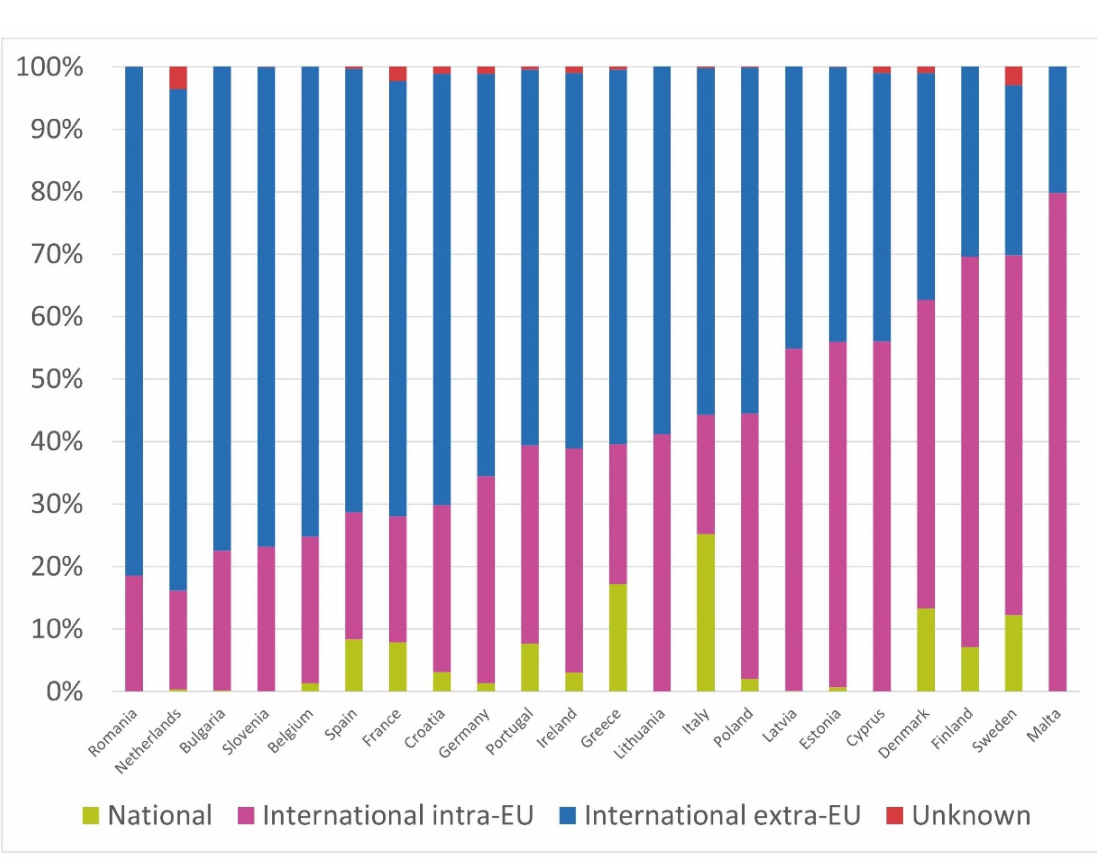
Figure 3. Seaborne transport of freight between main ports in the reporting country and their partner ports grouped by main geographical areas, 2020. Data processed from Eurostat